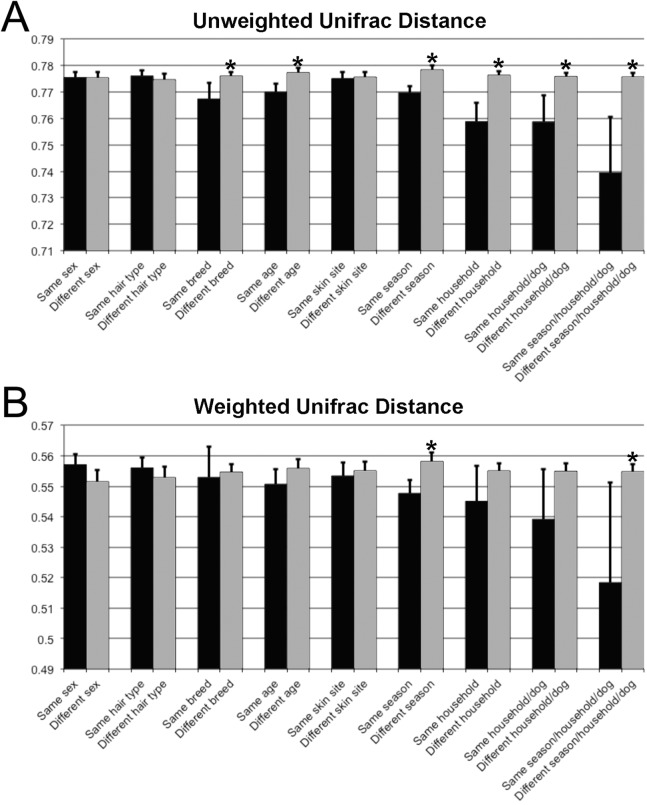
Comparison of unweighted and weighted Unifrac distance matrices between samples when grouped by a variety of different criteria.‘Same’ indicates average dissimilarity between samples within the same grouping, whereas ‘different’ indicates average dissimilarity between samples between different groupings. (A) Uses unweighted Unifrac distances and (B) uses weighted Unifrac distances. Those comparisons that are statistically significant (P < 0.05) are indicated with asterisks. Error bars represent 95% confidence intervals.